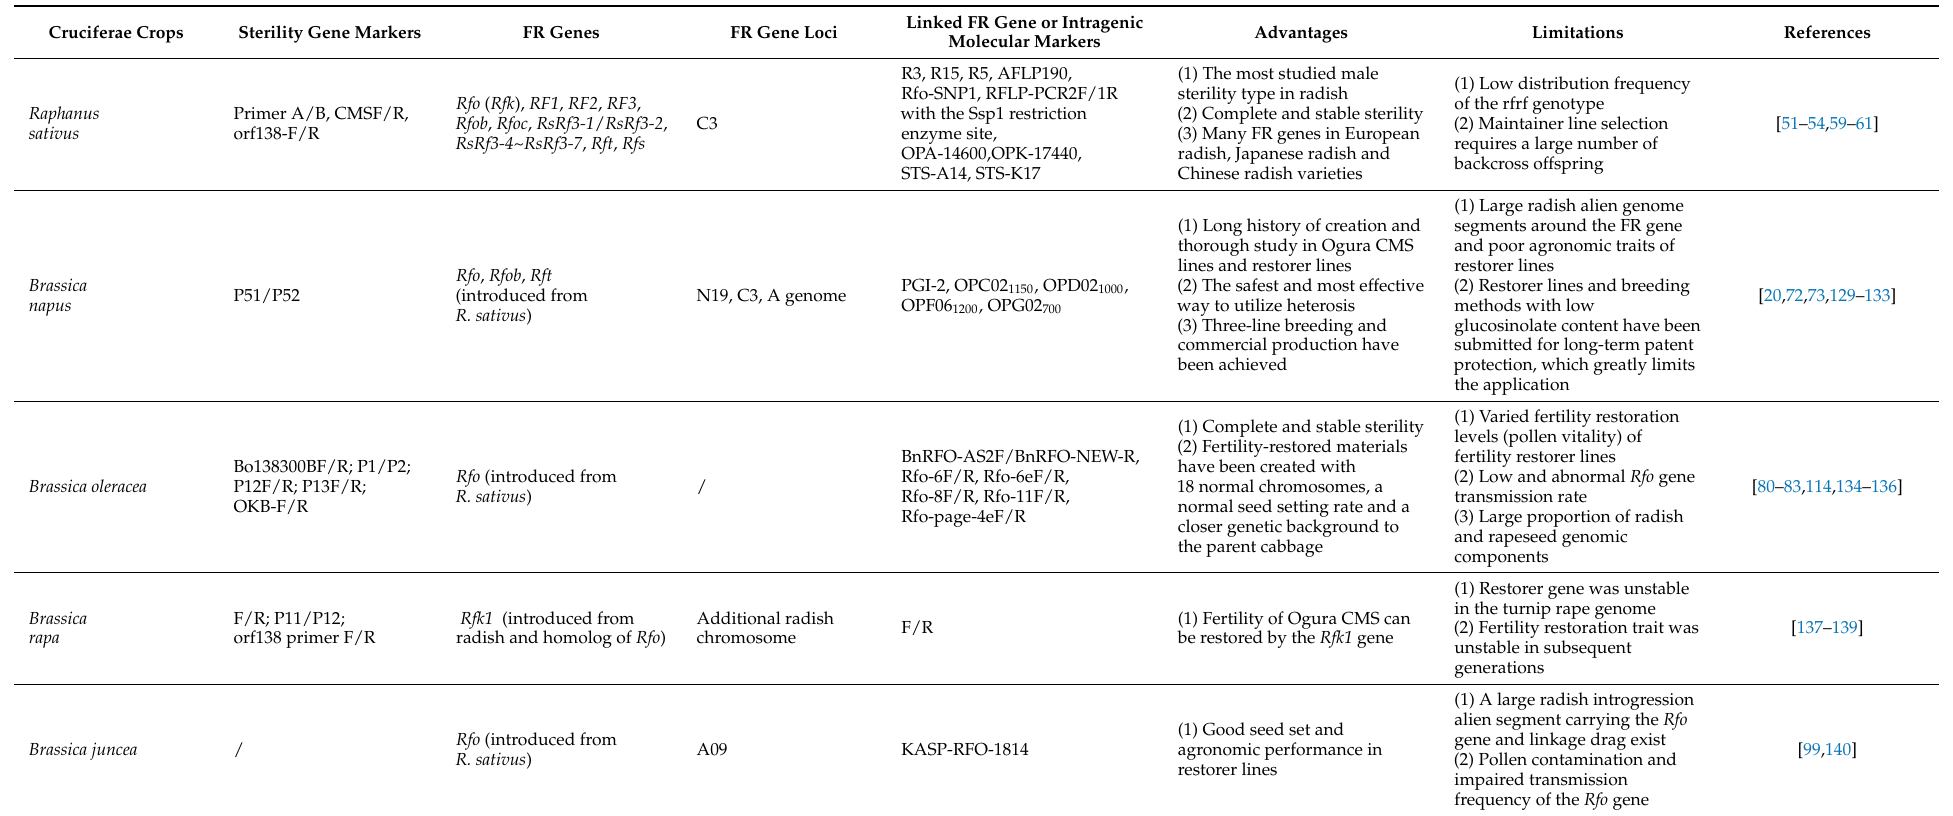
Table 2. Comparative analysis of Ogura CMS systems in different Cruciferae